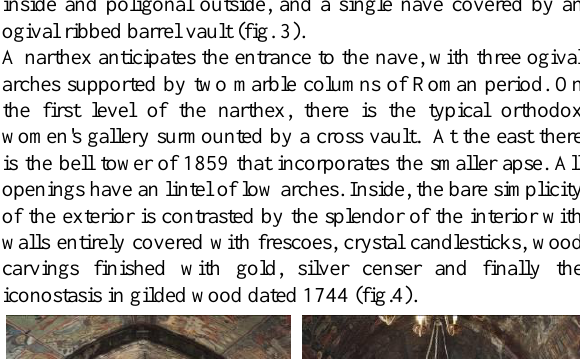
Figure 6. In situ acquisition